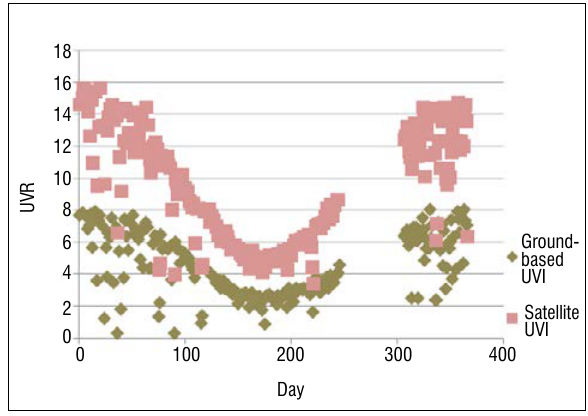
Satellite-based and ground-based measurements of solar ultraviolet radiation (UVR) measured as an ultraviolet index (UVI) over Pretoria for